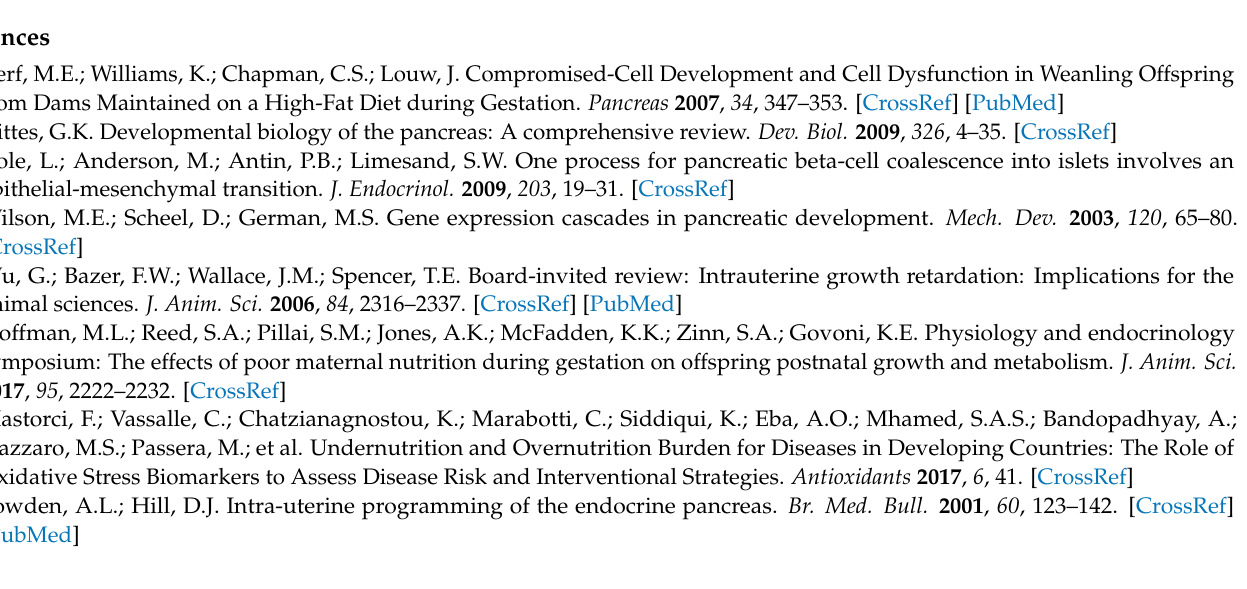
Table S3: DMRs CON v OVER Females, Table S4: DMRs CON v OVER